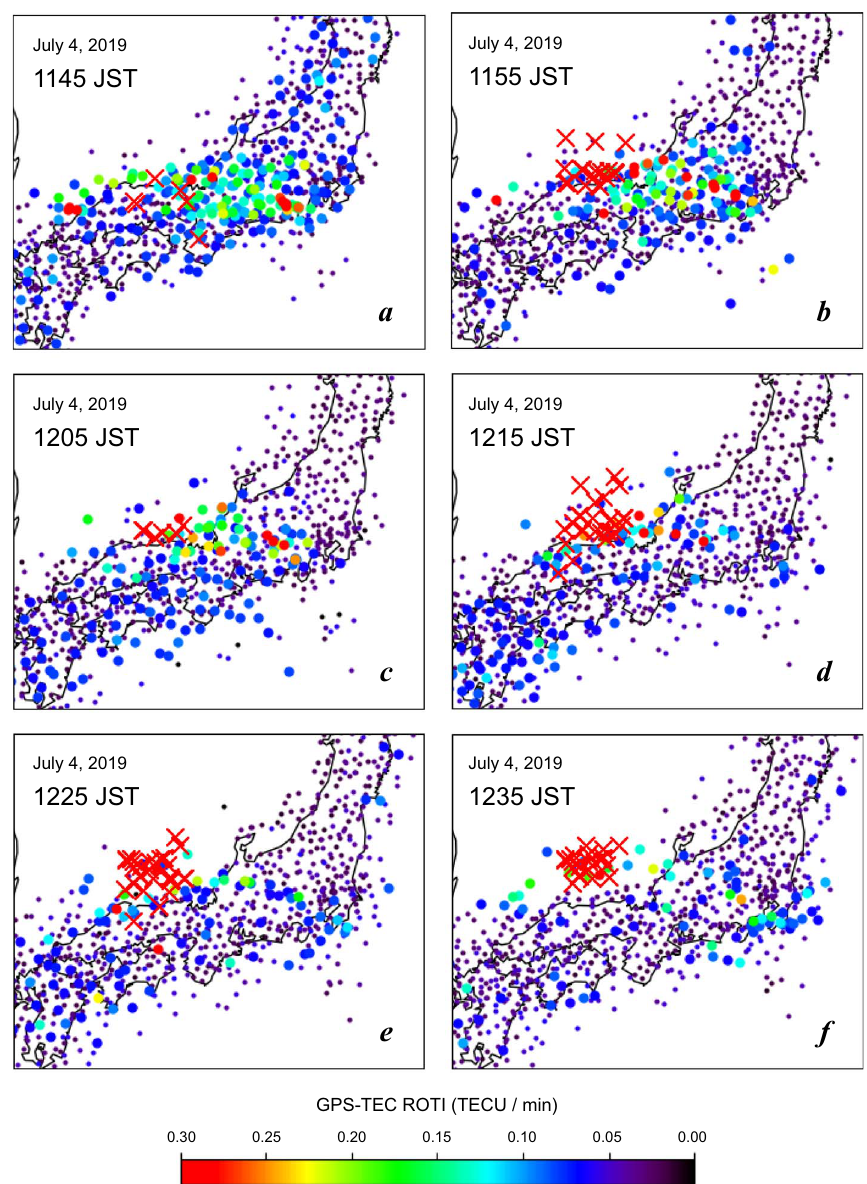
Fig. 4. Zoom-in views of the anomalous propagation data and ROTI sampled every 10 min from 1145 to 1235 JST on July 4,